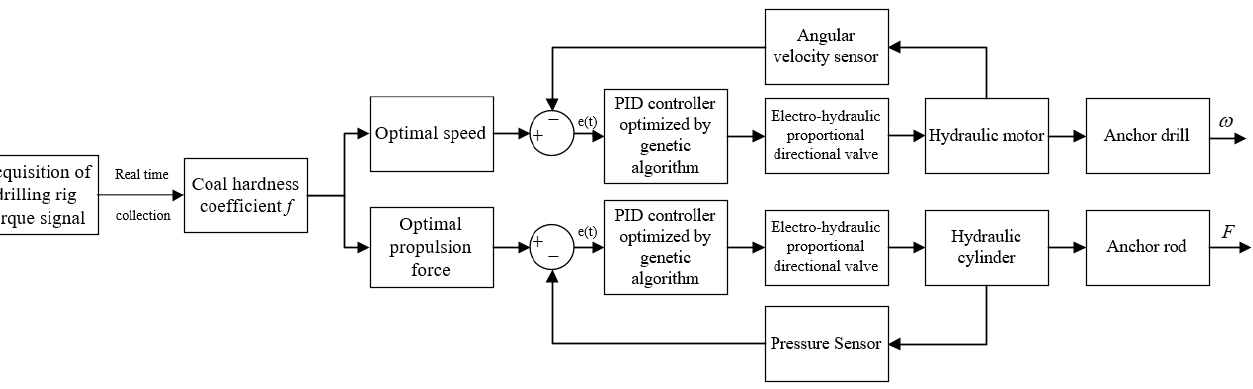
Figure 1. The control strategy diagram of the adaptive rotary propulsion system of the air-borne bolting rig.